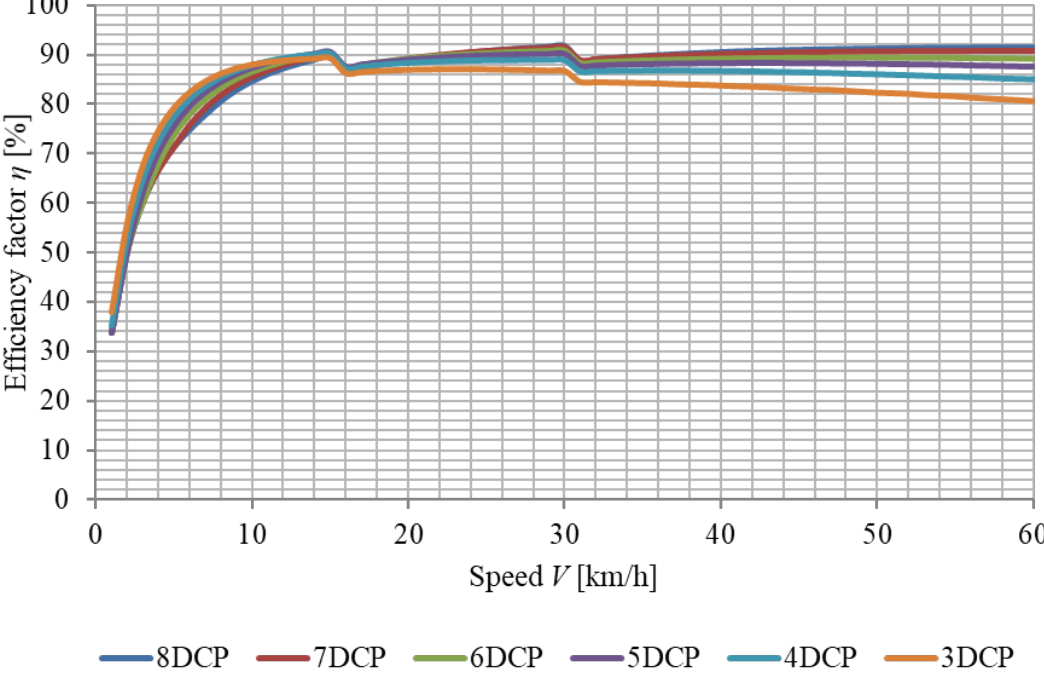
Figure 7. Dependence of efficiency on velocity for different positions of the driver’s controller (3DCP-8DCP—position number of the driver’s controller from 3 to 8, respectively). Source: own work.